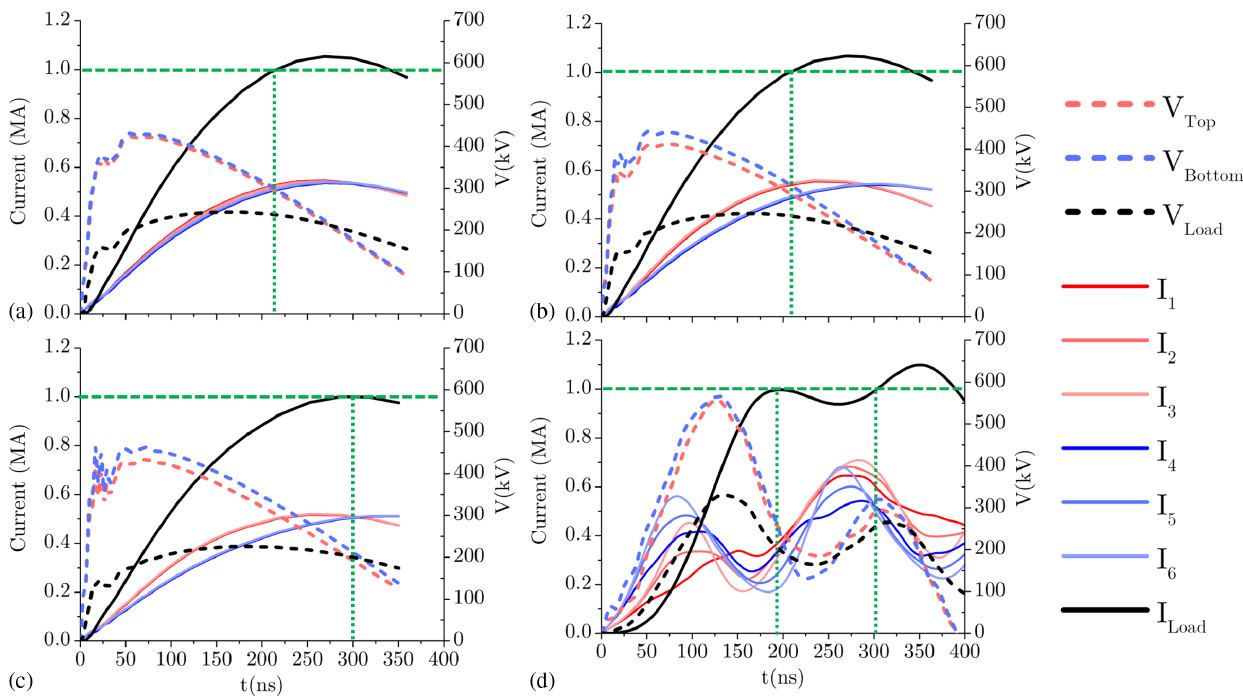
lines.FIG. 7. Time evolution of the current for a 20 nH = 0 . 2 Ω load with (a) wrapped, (b) conical, (c) straight, and (d) conical with water transmission lines using COMSOL . The currents I 1 to I 6 are the current in the cavities 1 –